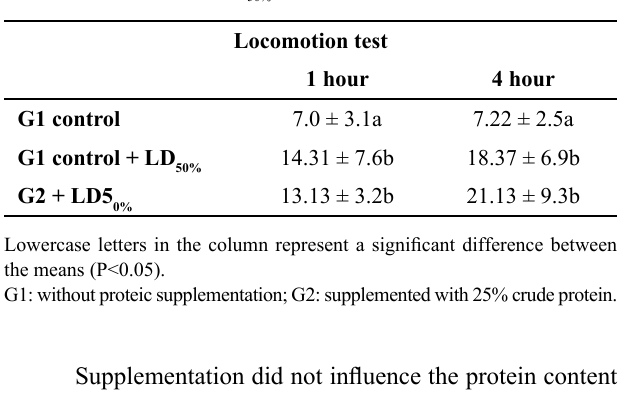
Table 2 . Locomotion (seconds) of honeybees Apis mellifera Africanized supplemented or not with 25% of crude protein and challenged or not with LD of fipronil. 50%